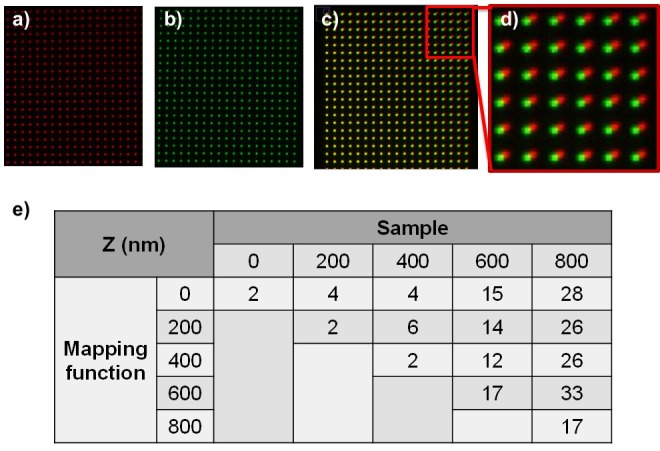
Correcting chromatic aberration using nanohole pattern.We made 100 nm size hole every 1.5 µm on the silver coated glass coverslip. When illuminating white light through the nanohole pattern, each color image can be taken using a band pass filter.